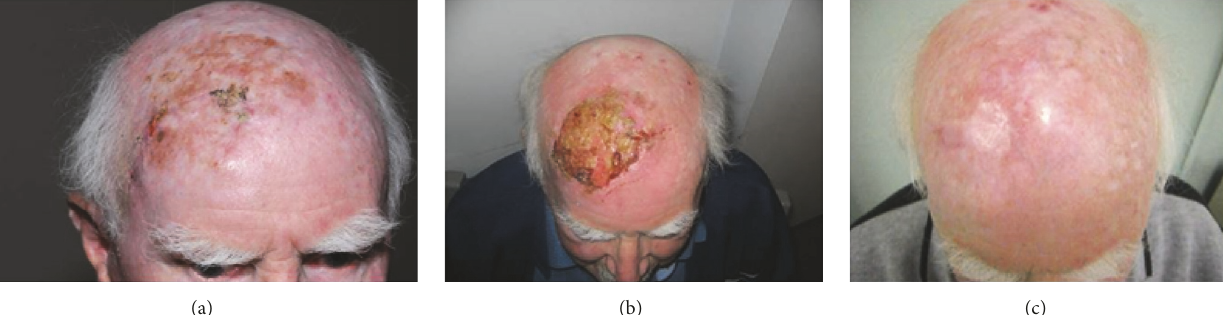
Figure 10: (a) This gentleman with a large 10 x 10 cm deposit of lentigo maligna on the right anterior scalp that had already grown into significant invasive melanoma. He was treated with external beam radiotherapy alone. (b) In the next figure, the acute reaction can be seen. He has an acute grade 3 reaction of wet desquamation. (c) Six months later, the final photo shows all the lentigo maligna has responded.